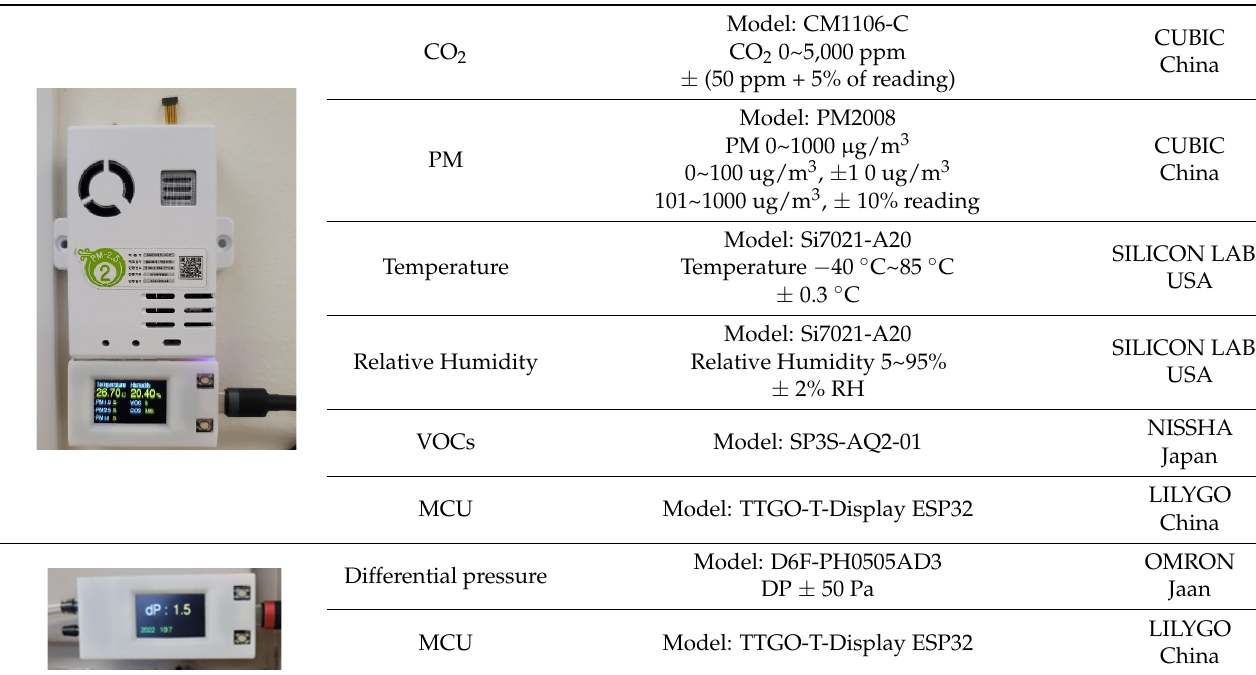
Figure 2. The concept of data mining and sensor configuration. Table 2. The Internet of Things sensor specification. Sensors 2023 , 23 , x FOR PEER